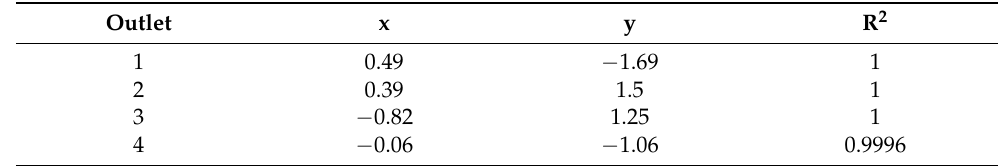
Figure 15. Thermal homogenisation indicator for different heat pipe performances and positions . As the output at position 2 represents a new, excessively high mass flow, the integra- tion of another heat pipe could be helpful to homogenise the temperature and mass flow distribution. Therefore, the integration of another heat pipe is tested by integrating two heat pipes symmetrically, as shown in Figure 16. To cool down the temperature at outlets 2 and 3, and since the average temperature at outlet 3 is higher than at outlet 2 (Figure 6), the cooling rates of the heat pipes at position 3 ′ are set lower than at position 3. The dif- ference between the two positions is 10 K/s and 20 K/s, respectively. Maximum cooling rates of up to − 70 K/s are simulated, with all cooling rates listed in Table 3. The extrusion operating point remains the same.